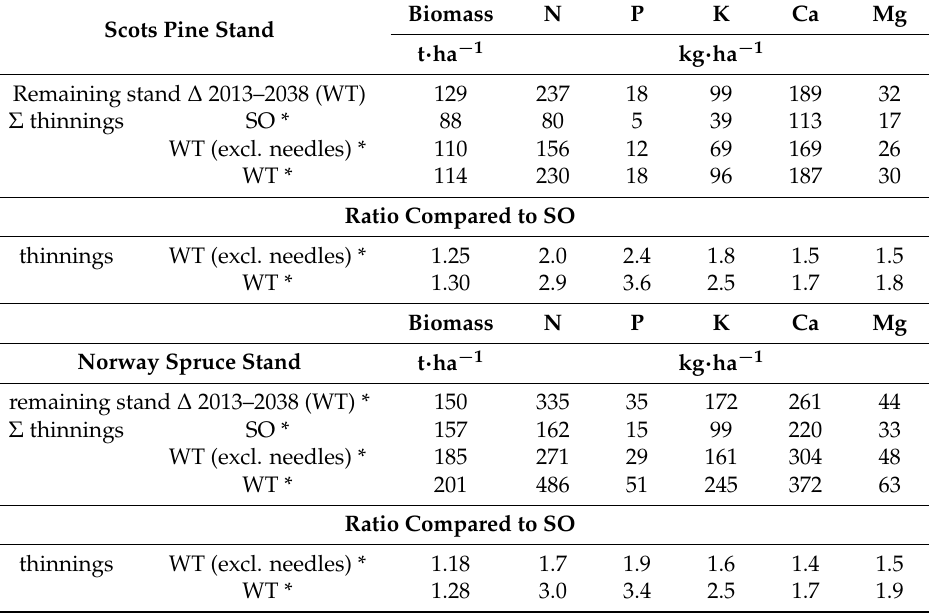
Table 6. Aboveground biomass increment and nutrient uptake/storage in the remaining stand. Biomass Scots Pine Stand